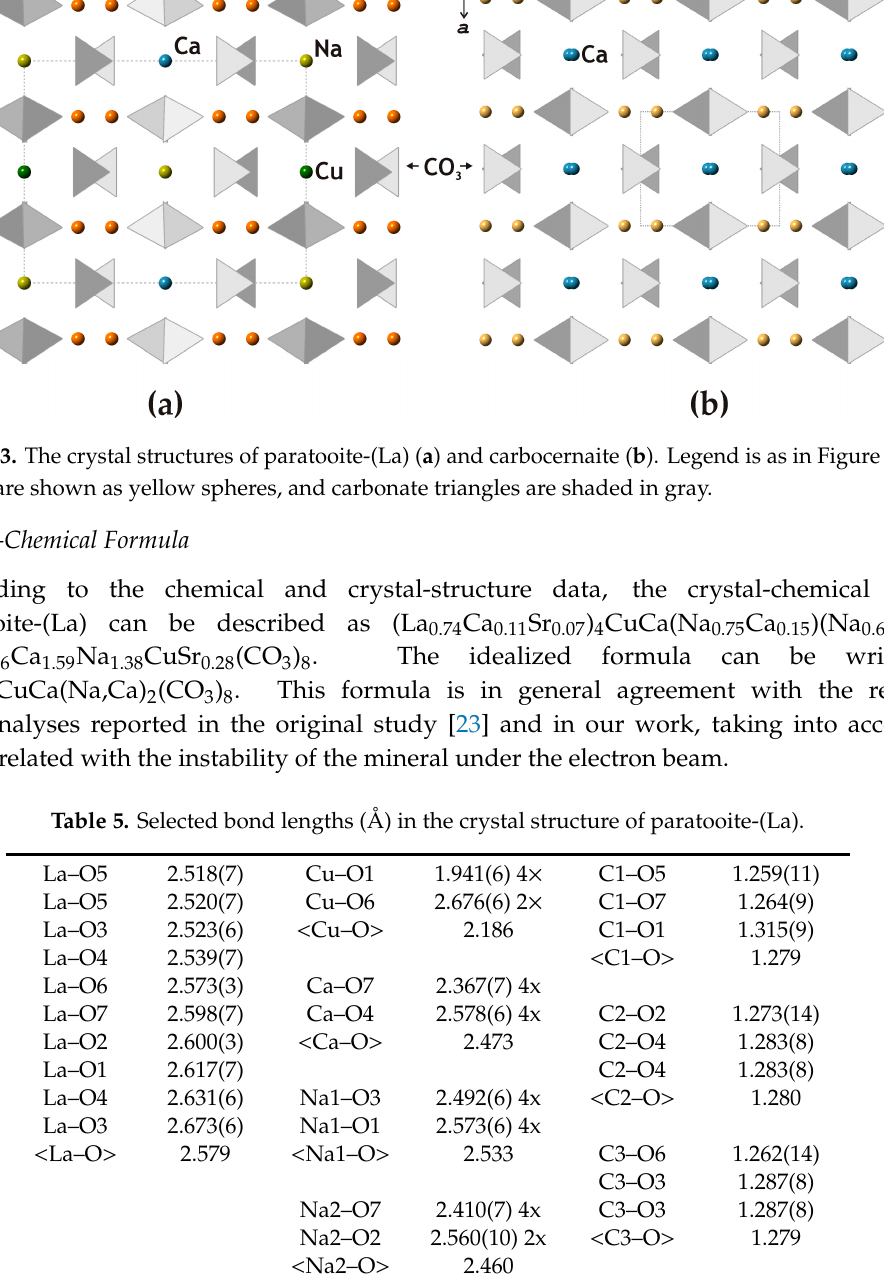
Figure 2. Coordination environments of the La, Ca, Cu, Na1, and Na2 sites in the crystal structure of paratooite-(La). Legend: La, Ca, Na, C, and O atoms are shown as orange, blue, greenish-yellow, gray, and red spheres, respectively.